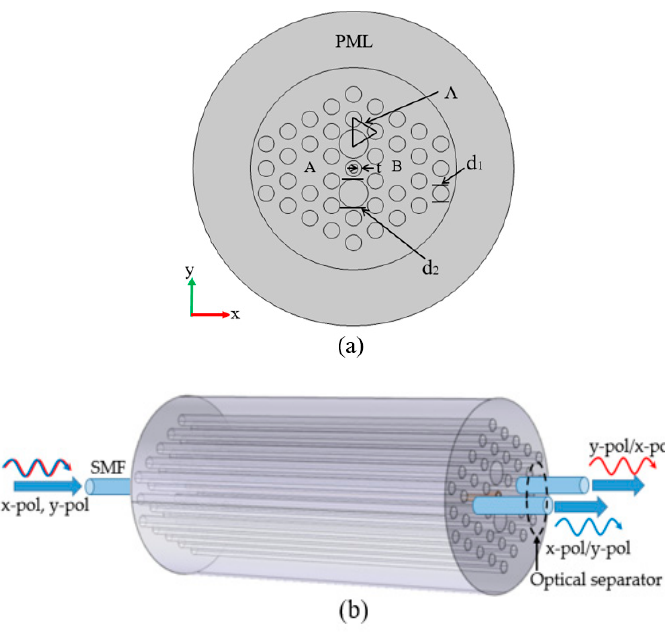
Figure 1. ( a ) Cross-section of the proposed photonic crystal fiber-polarization beam splitter (PCF-PBS). ( b ) Schematic diagram of the PBS operation, where an incident light with the x- and y-pol modes enters the input port, and the x- and y-pol modes can be split out at the output port.